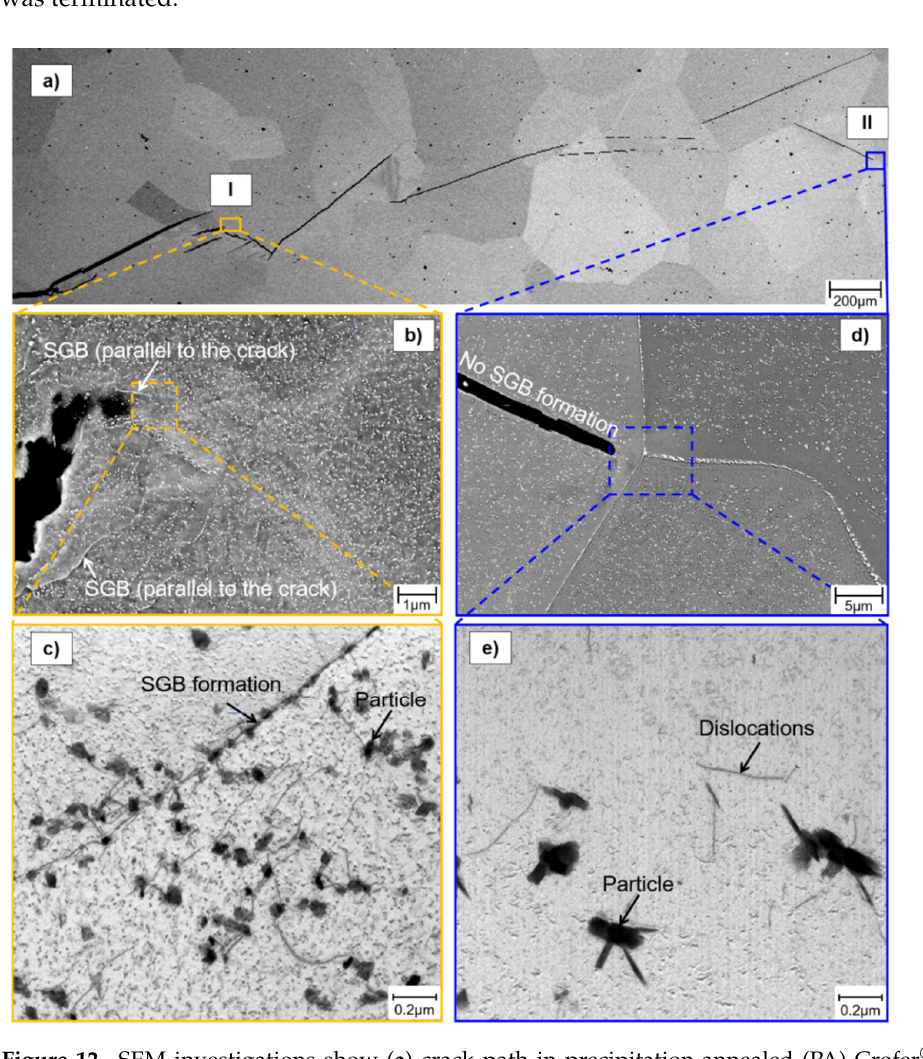
Figure 13. SEM micrographs of crack deflection at Laves phase particle covered sub-grain bounda- ries in precipitation-annealed (PA) Crofer ® 22H.